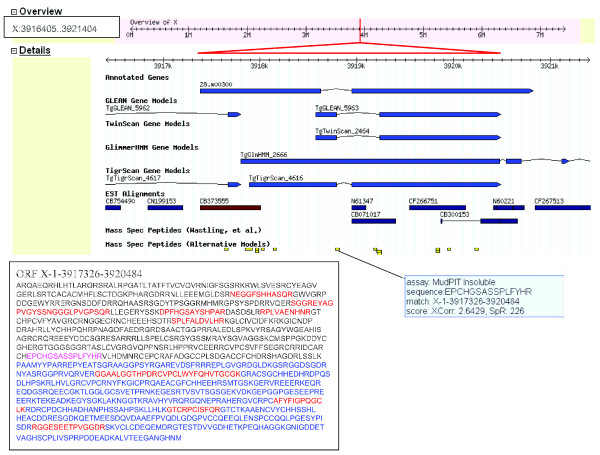
Peptide evidence indicating alternative exon positioning and sequence annotation. The position of ORF X-1-3917326-3920484 in the genome scaffold is indicated by a red line on the grey track at the top of the figure and this region is expanded below, the red triangle demarking the ORF length. Predicted exons are indicated as blue boxes, linked by zigzag lines to indicate the position of exon/intron boundaries. Gene 28.m00300 is shown with two exons. ESTs are shown as dark blue or brown boxes. Peptides aligning with this region are shown in yellow. The predicted sequence for ORF X-1-3917326-3920484 is shown as an insert and sequence that matches exon 2 of gene 28.m00300 is shown in blue. Sequence for which there is matching peptide evidence is shown in red. Purple lettering indicates the positioning of the 'intron-located' peptide, mass spectrometric evidence for which is shown in the right hand insert.